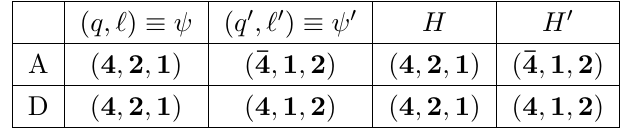
SU(2) L SU(2) R embedding of SU(2) (cid:2) (cid:2)